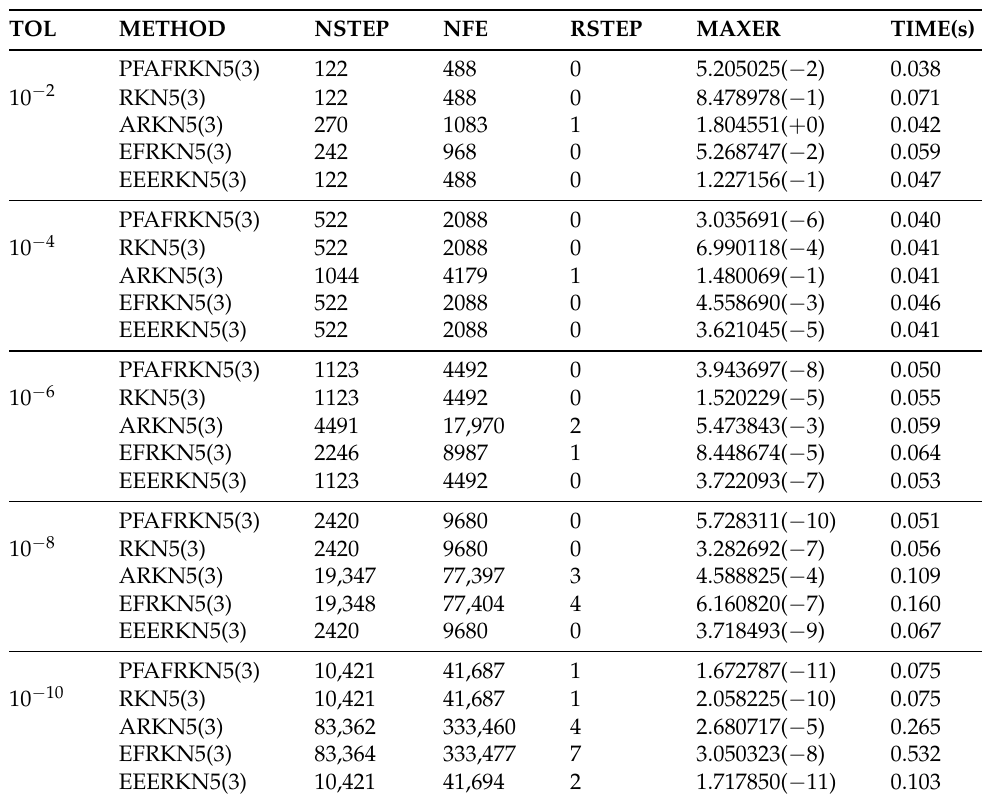
Table 3. Numerical data corresponding to Problem 2.